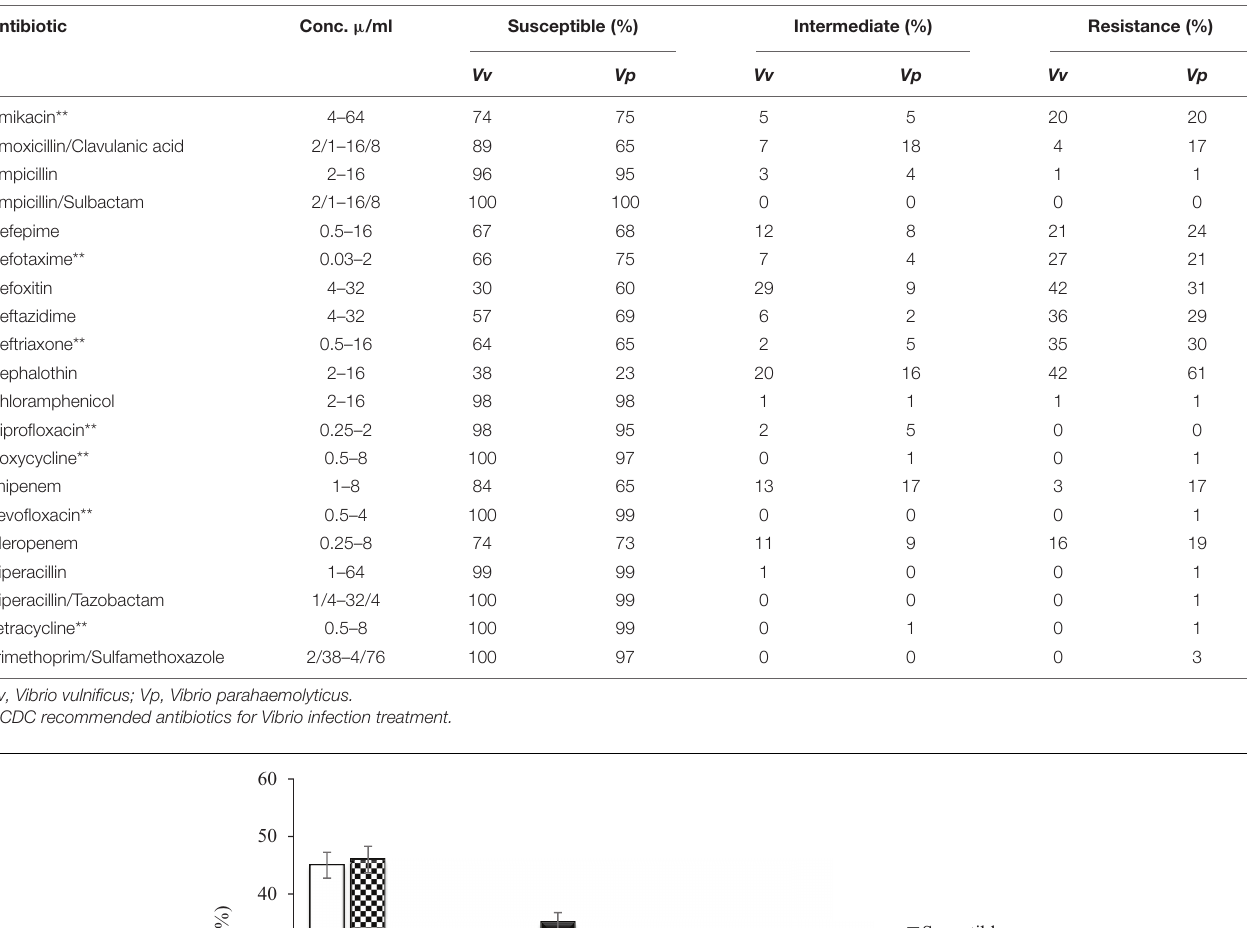
TABLE 2 | Vibrio vulnificus and Vibrio parahaemolyticus antimicrobial profile. Antibiotic Conc. µ /ml